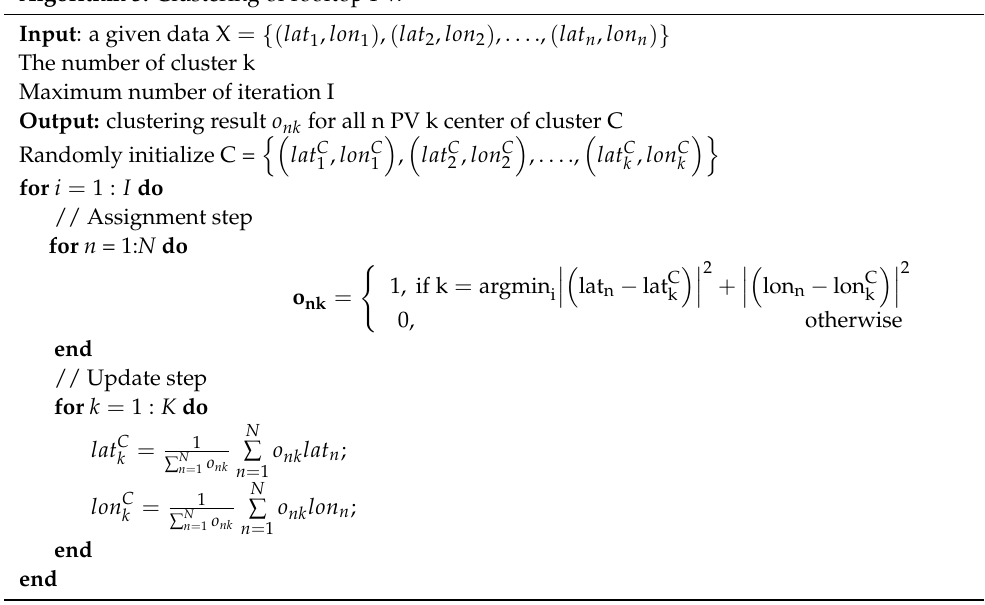
Algorithm 3. Clustering of rooftop